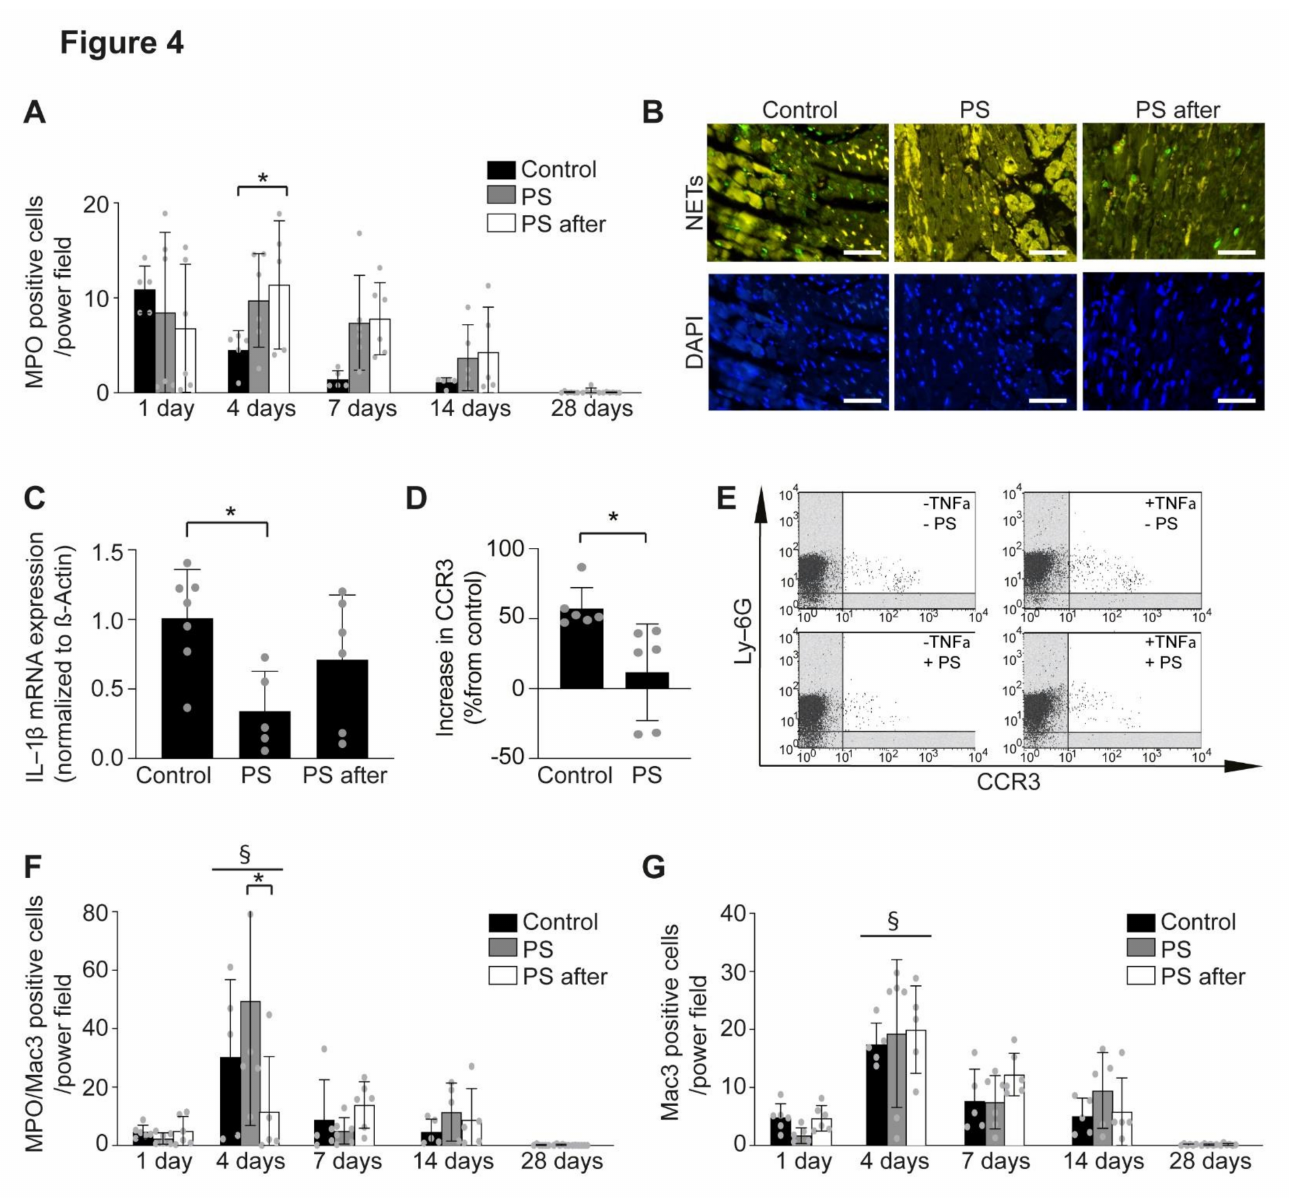
Figure 4. The effect of phosphatidylserine on neutrophils and inflammation after AMI. ( A ) Phosphatidylserine treatment increased the number of neutrophils in the infarcted area as assessed by MPO-positive cells at different time points after AMI, when compared to control ( n = 5–6, Two-way ANOVA, Bonferroni’s multiple comparison Test, * p < 0.05, Values ± SD). ( B ) Representative images of NETs (upper panel, H3cit staining, green) and DAPI (lower panel, blue) 24 h after induction of AMI (scale bar 50 µ m). ( C ) Phosphatidylserine treatment decreased IL-1ß mRNA expression in AMI, when compared to control ( n = 5–7, One-way ANOVA, Turkey’s multiple comparison Test, * p < 0.05, Values ± SD). ( D ) Phosphatidylserine treatment suppressed the increase in CCR3 expression in TNF- α -stimulated or unstimulated neutrophils when compared to control ( n = 6, unpaired Student’s- t test, * p < 0.05, Values ± SD). ( E ) Representative dot plots of FACS from neutrophils stimulated or not with phosphatidylserine. ( F ) MPO and Mac3 double positive cells in staining of infarction area by immunofluorescence at different time points after AMI in control (Control) and phosphatidylserine treated mice (PS, PS after) ( n = 5–6, Two-way ANOVA, Bonferroni’s multiple comparison Test, * p < 0.05, § < 0.05 vs. 1 day, Values ± SD). ( G ) Mac3 positive cells in staining of infarction area by immunofluorescence at different time points after AMI in control (Control) and phosphatidylserine treated mice (PS, PS after) ( n = 5–6, Two-way ANOVA, Bonferroni’s multiple comparison Test, § < 0.05 vs. 1 day, Values ±